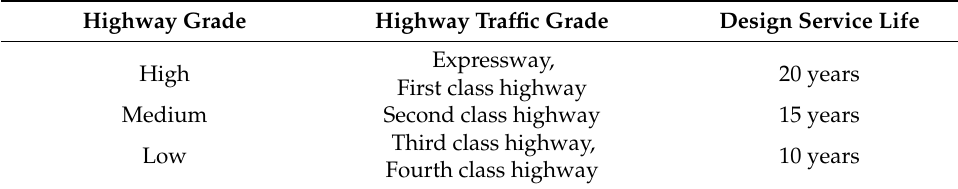
Table 1. Standards for dividing highway grade indicators.